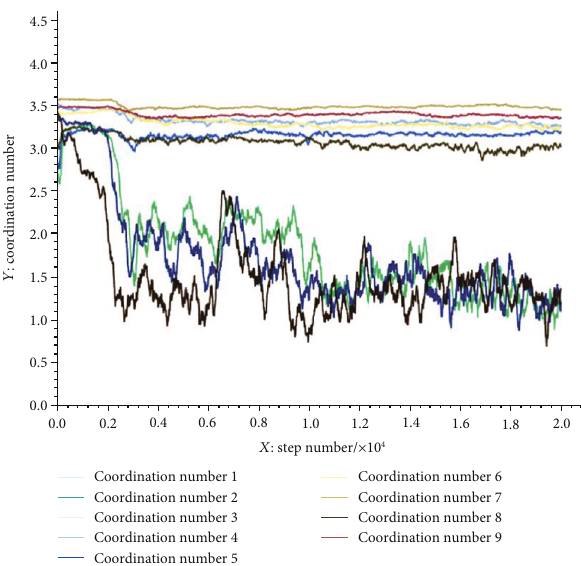
Figure 7: Monitoring results of the coordination number.